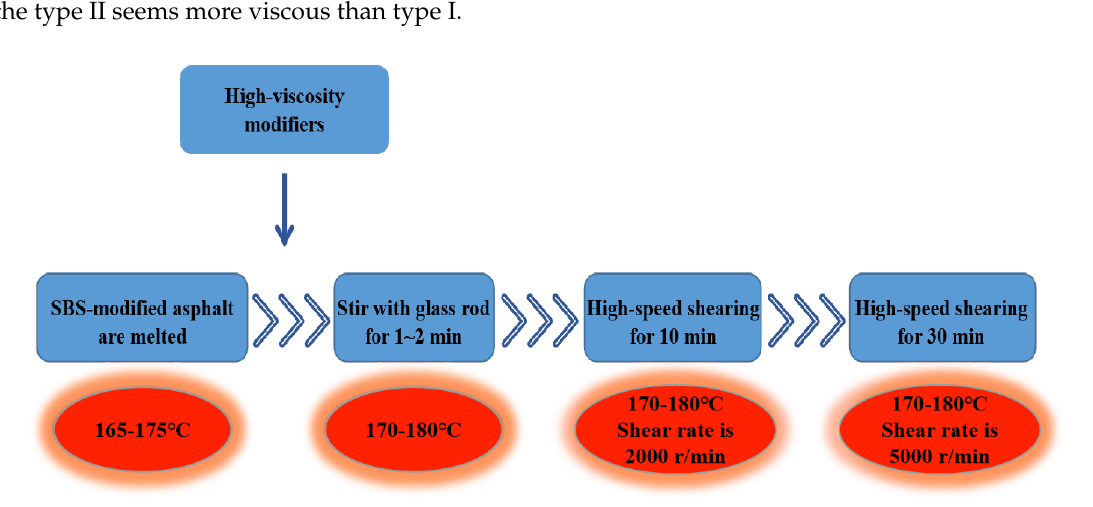
Figure 2. Preparation of high-viscosity modifier-modified asphalt.